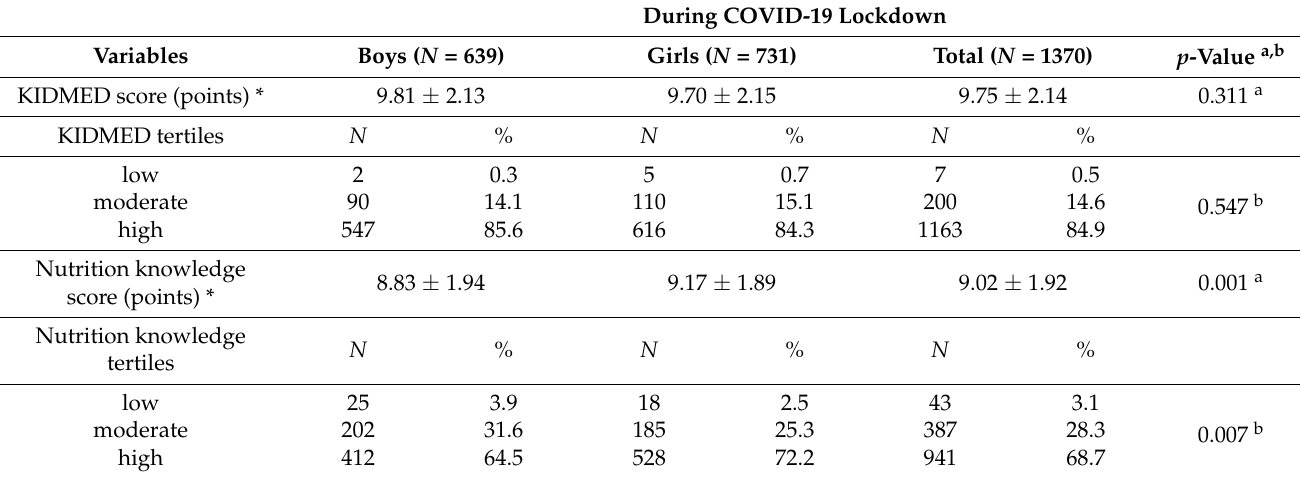
Table 2. Dietary habits and nutrition knowledge of participants during COVID-19 lockdown. During COVID-19